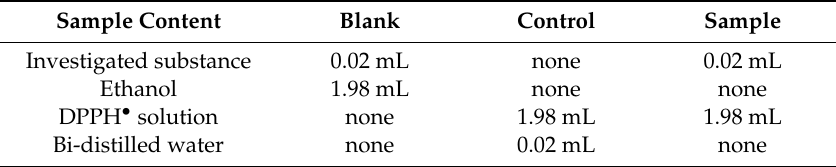
Table 2. Sample composition for the DPPH • assay.